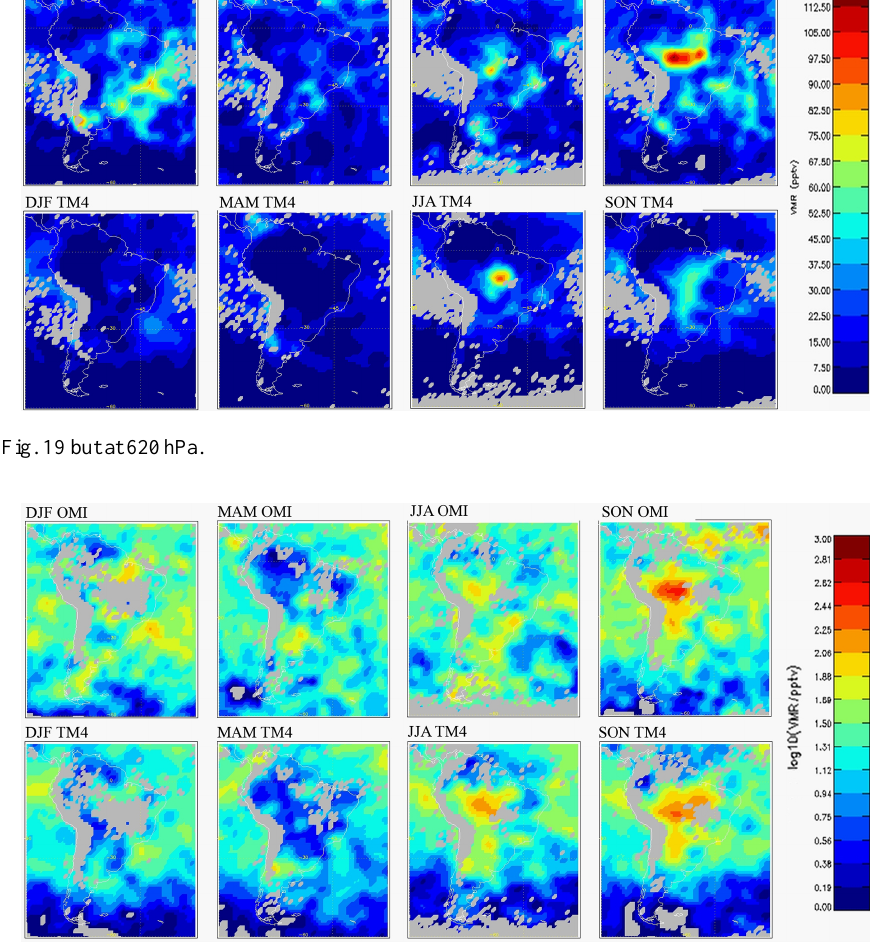
Figure 23. Same as Fig. 19 but at 720hPa in logarithmic